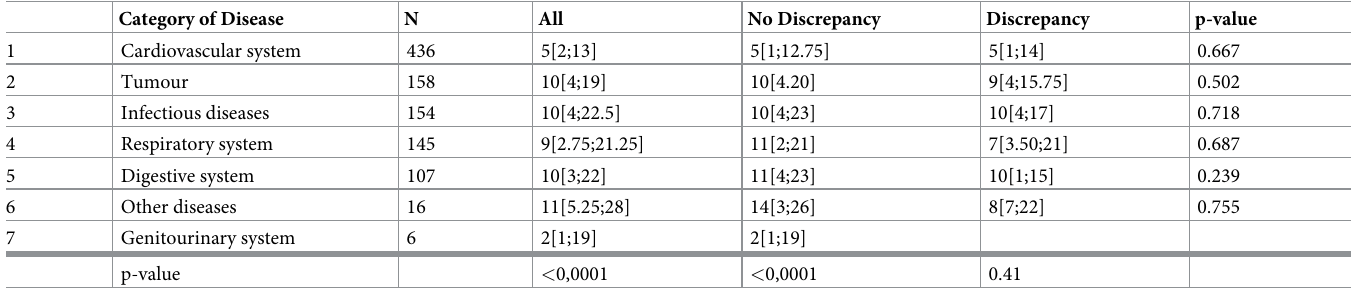
Table 3. Table 3 represents the differences between groups of discrepancy, category of disease and duration of hospitalization of patients. Category of Disease